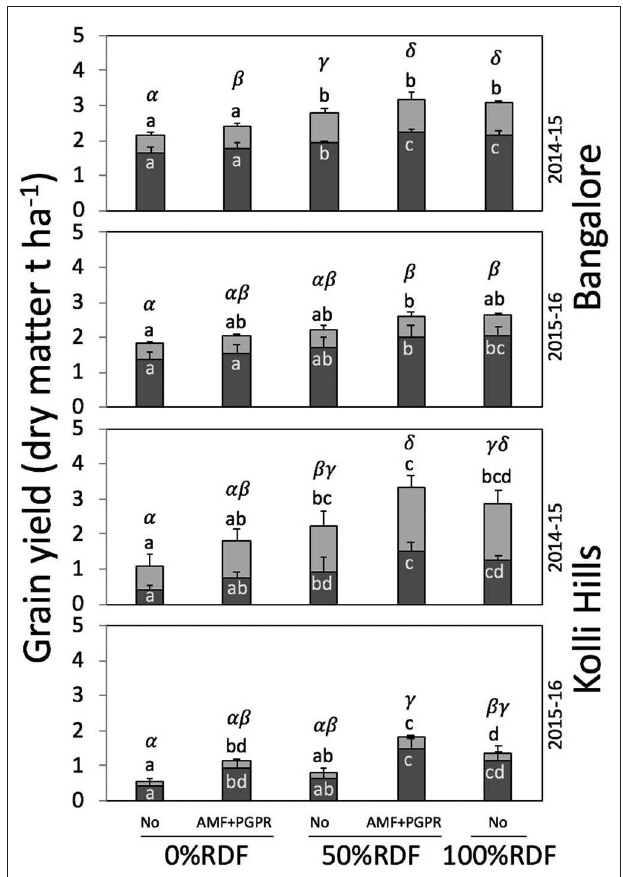
FIGURE 4 | Effect of combined biofertilizer inoculation on grain yield of finger millet (dark shaded bars) and pigeon pea (light shaded bars) in the intercropping system at the 0% recommended dose of fertilizer (RDF) and at 50% RDF as compared to no inoculation at 0, 50, and 100% RDF. Significant differences among means were calculated crop wise. Means were compared crop wise across fertilizer levels. Each error bar represents + 1 standard deviation of the mean. Alpha ( α ) and beta ( β ) above the bars indicate letters of significance for combined grain yields of finger millet and pigeon pea. Bars not sharing the same letters are significantly different at p < 0.05.